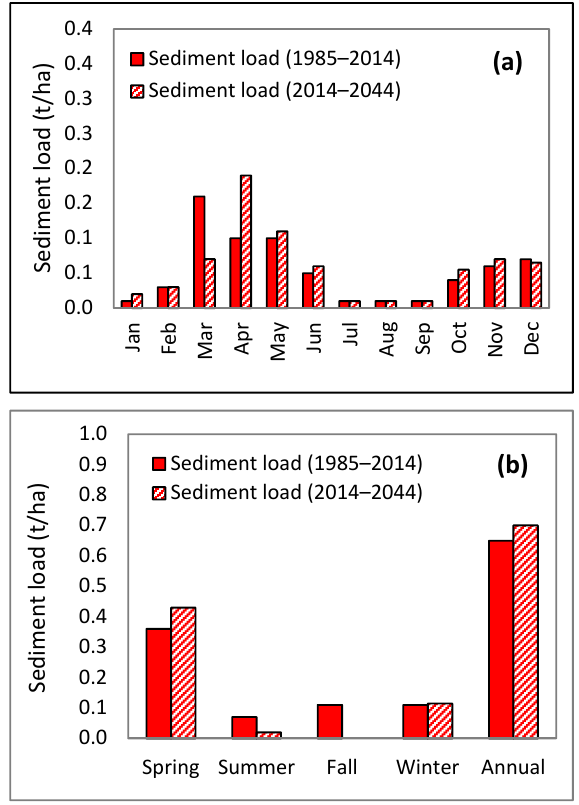
Figure 6. Historical and future simulated monthly ( a ) and seasonal ( b ) sediment loads.